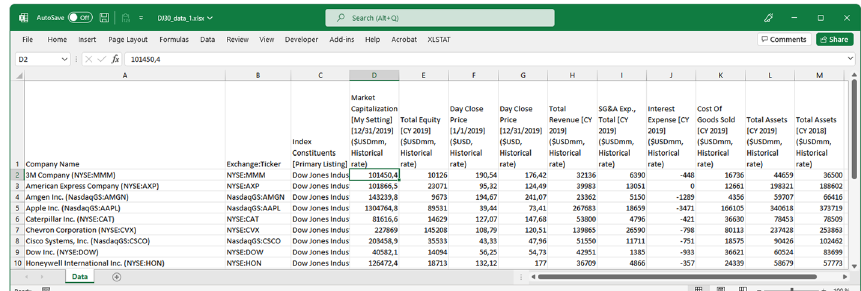
Fig. 13 Sample of an MS Excel file with the data required for the portfolio classification. Source : Created by